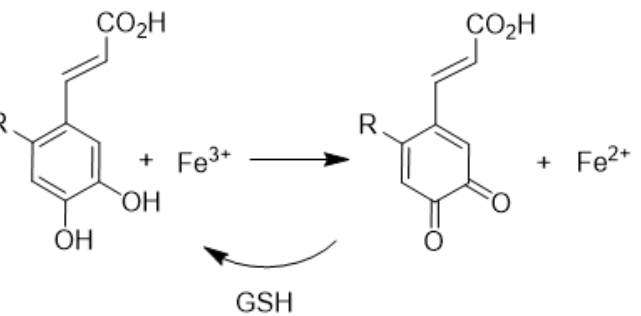
Figure 5. Production of iron (II), the colorimetric product of the FRAP assay, by caffeic acid, and the recycling of the quinone product back to the reactant by glutathione (GSH). This recycling will result in producing more iron (II) per unit of caffeic acid. R=H or GS (glutathionyl).